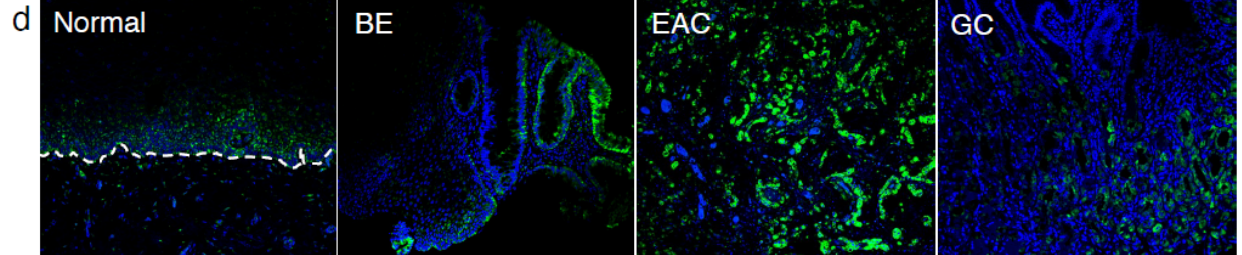
Figure 1. Expression of CPT1A is increased in the sequence from normal esophageal squamous epithelium to BE and EAC. ( a ) Comparison of CPT1 component expression and CD36 between normal esophagus (NE), Barrett’s esophagus (BE) and gastric cardia (GC) using the GSE34619 dataset (8 patients normal squamous, 10 with BE and 10 gastric cardia). * p < 0.05 Student’s t -test ( b ). Expression of CPT1A, CPT1B and CD36 in normal esophagus (NE), Barrett’s esophagus (BE) and esophageal adenocarcinoma (EAC) tissues in the publically available dataset GDS1321/GSE1420; 8 patients with Barrett’s associated adenocarcinomas. ( c ) Composite score and quantification of immunofluorescent staining using antibody against CPT1A in normal esophagus (NE), Barrett’s esophagus (BE) and esophageal adenocarcinoma (EAC) and matching normal adjacent tissues (NA). ( d ) Representative images of CPT1A immunofluorescence staining. * p < 0.05, Student’s t -test.